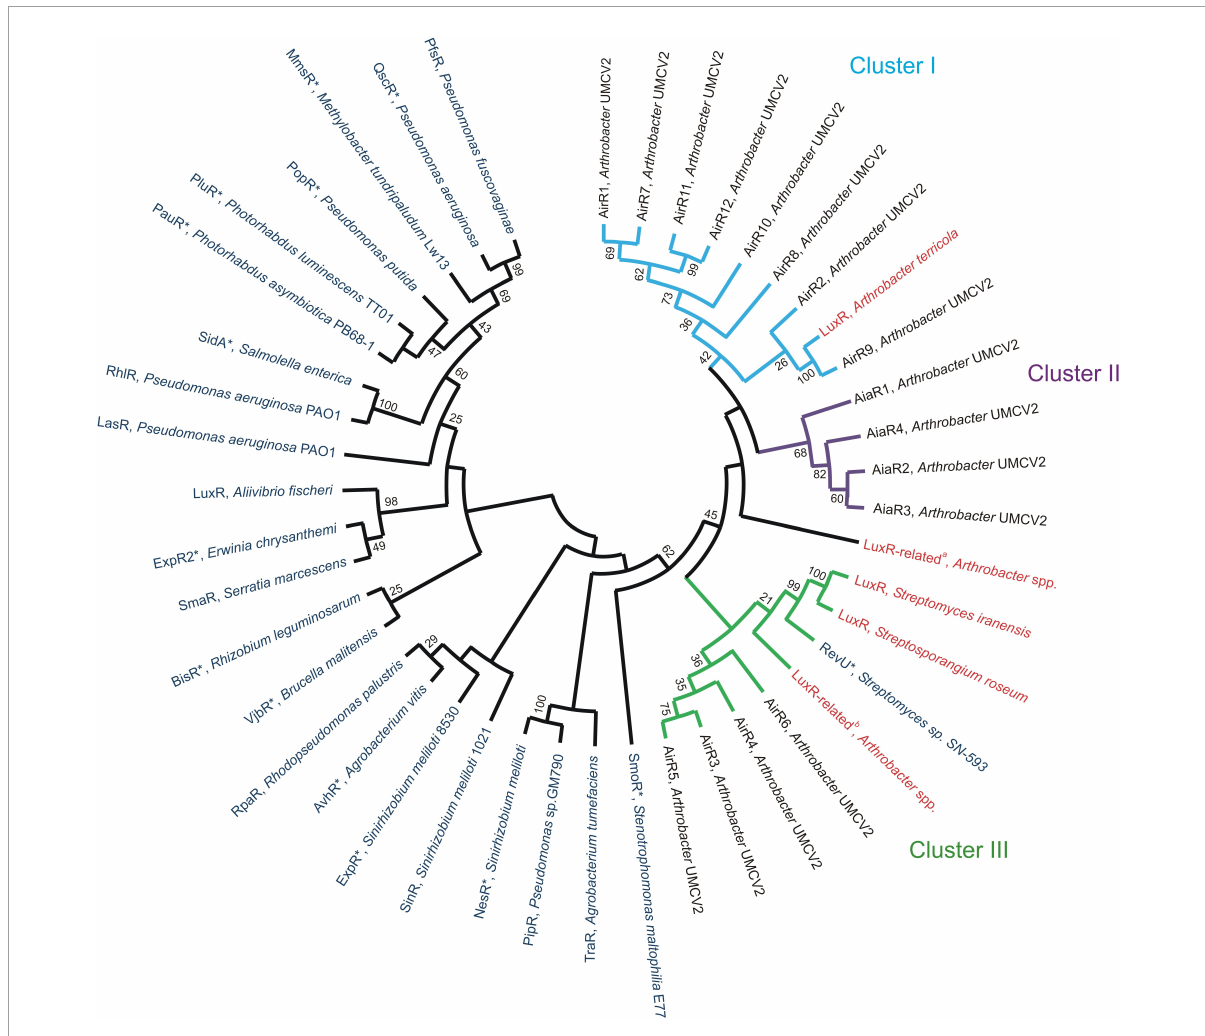
FIGURE4 Evolutionary relationships among Arthrobacter LuxR-related sequences. The evolutionary relationship was inferred using the Maximum Likelihood method and jones-taylor-thornton (JTT) matrix-based model. The bootstrap consensus tree was inferred from 1,000 replicates. Blue sequences have been experimentally characterized, red denotes sequences informatically characterized and black is Arthrobacter sp. UMCV2 sequences established in this work. Cluster I (light blue, sequences with domains IPR001789, and IPR000792 or IPR000792 alone), Cluster II (purple, sequences with domains IPR001789, and IPR001867), and Cluster III (green, larger proteins) are emphasized. Accession numbers of employed sequences are provided in Supplementary Table 5 . LuxR solos are marked with